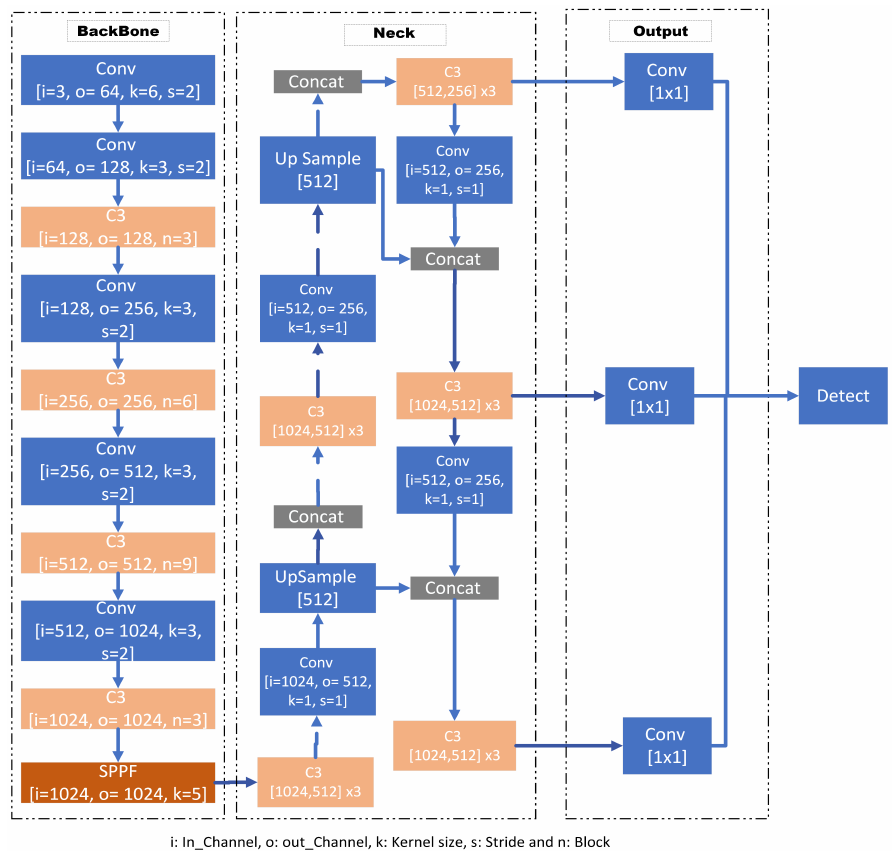
Figure 5. The architecture of the